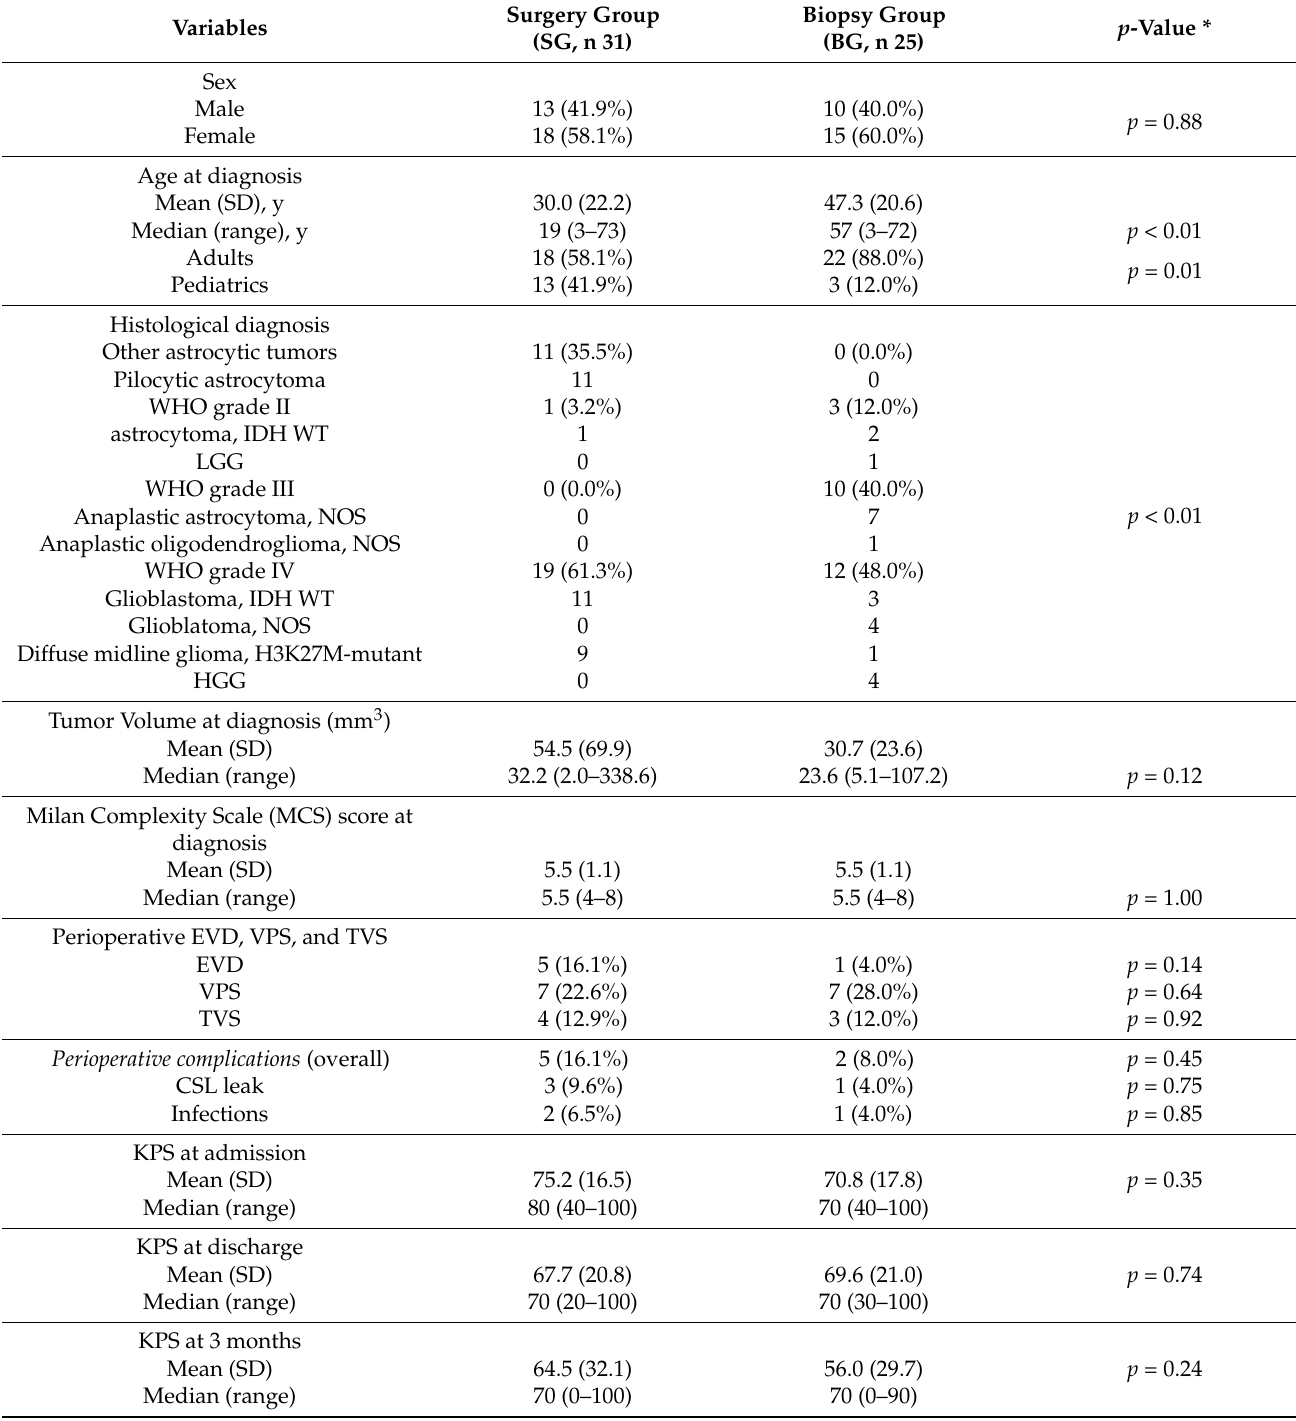
Table 1. Demographics, histological diagnosis and tumor